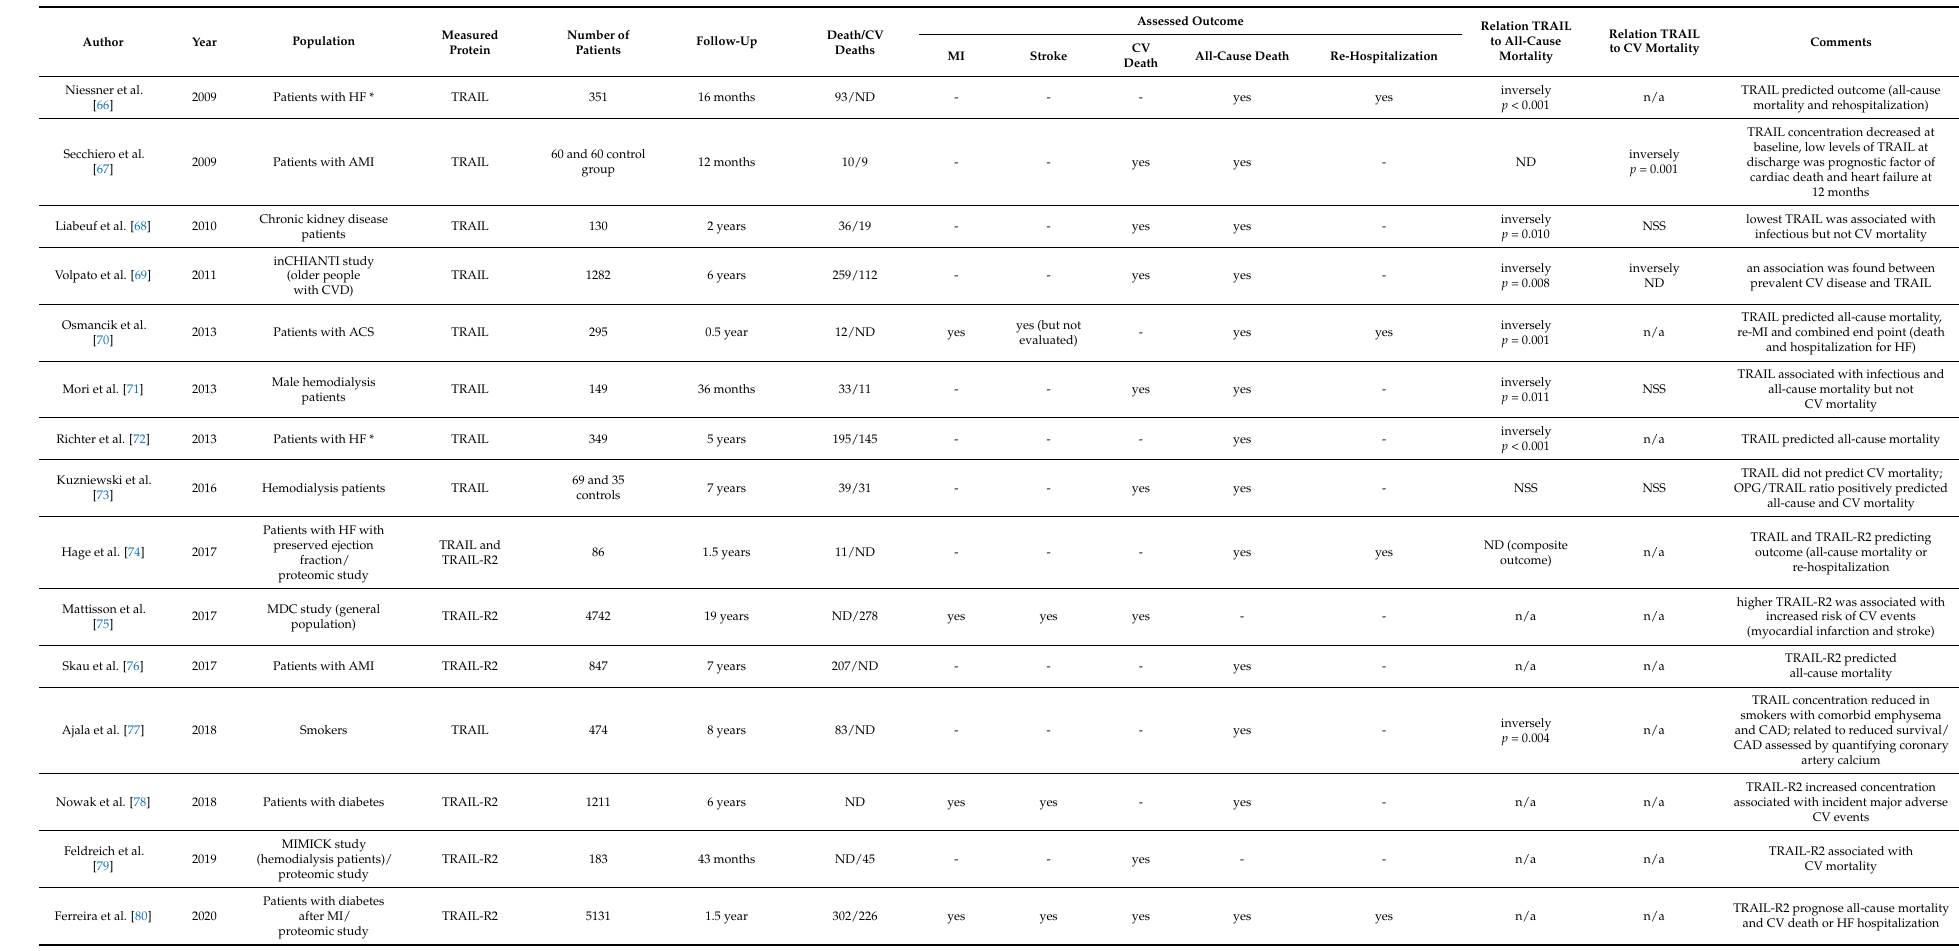
Table 3. Summary of the Studies Assessing the Association between TRAIL or TRAIL-R2 with Cardiovascular Patient-Related Outcome